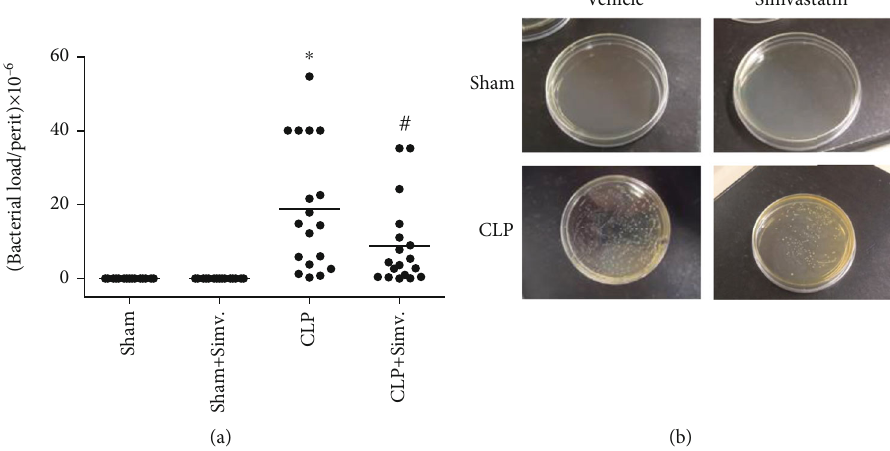
Figure 7: E ff ect of simvastatin treatment in the bacterial elimination in animals submitted to CLP. SW mice were treated with simvastatin 6 hours after sepsis induction. 24 hours after surgery peritoneal lavage samples were plated for CFU analysis (a). Representative images of CFU Petri dishes per group are shown (b). Data represented as mean ± SEM of at least 6 animals. ∗ p < 0 : 05 , control vs. CLP+ vehicle; # p < 0 : 05 , CLP+vehicle vs. CLP+